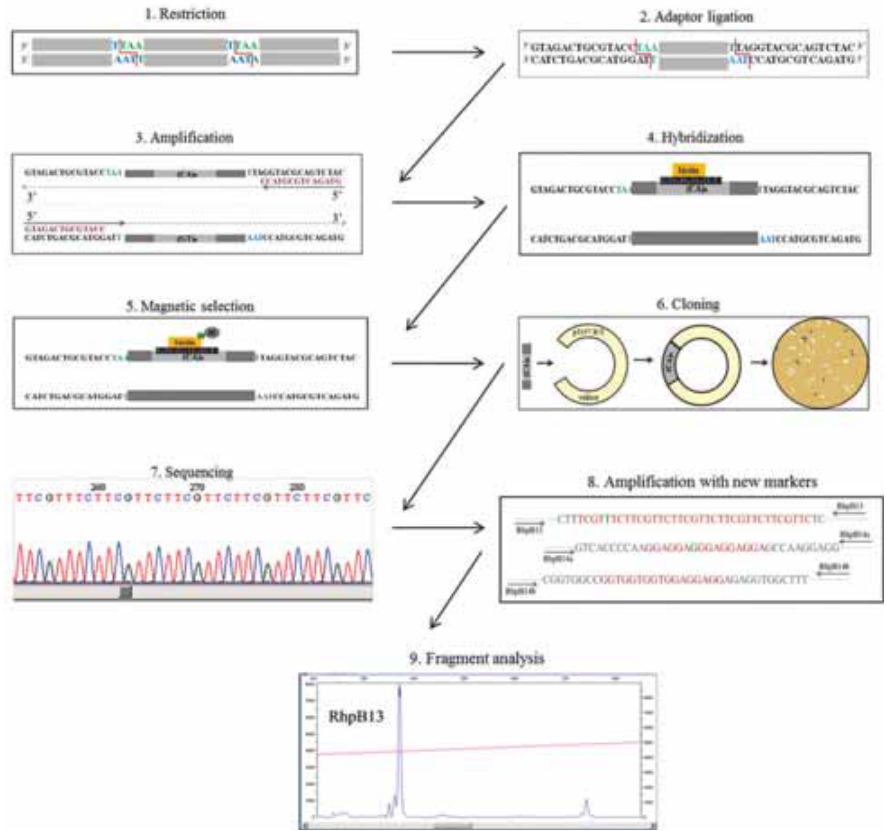
Figure 1. The protocol of the FIASCO